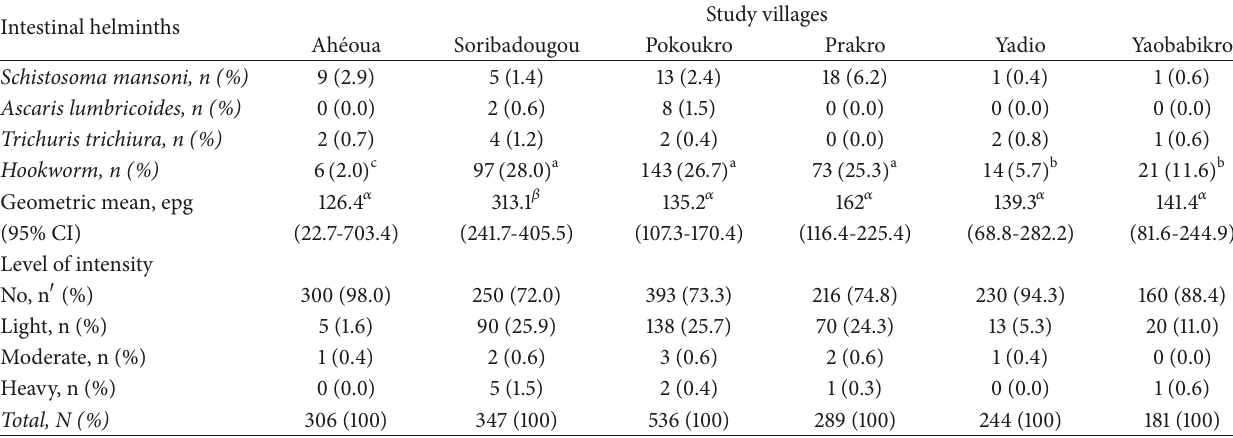
Table 1: Prevalence and intensity of intestinal helminths in eastern settings of Cˆote d’Ivoire. Intestinal